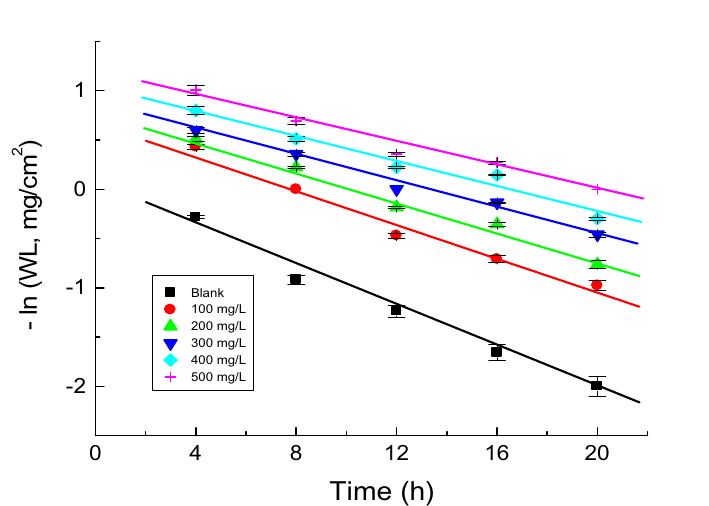
Figure 4. Langmuir adsorption isotherms for the adsorption of the examined surfactants on the copper surface in 1.0 M H 2 SO 4 solution at 298 K.